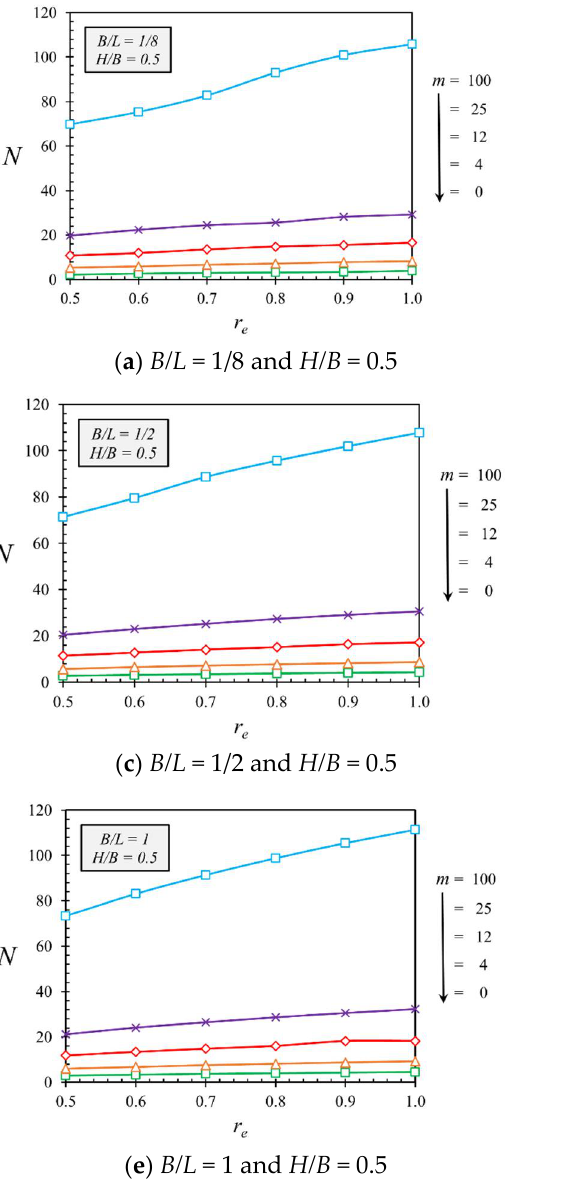
Figure 11. N vs. r e for the various m ( H / B = 0.5, 4.0 and B/L = 1/8, 1/2, 1).